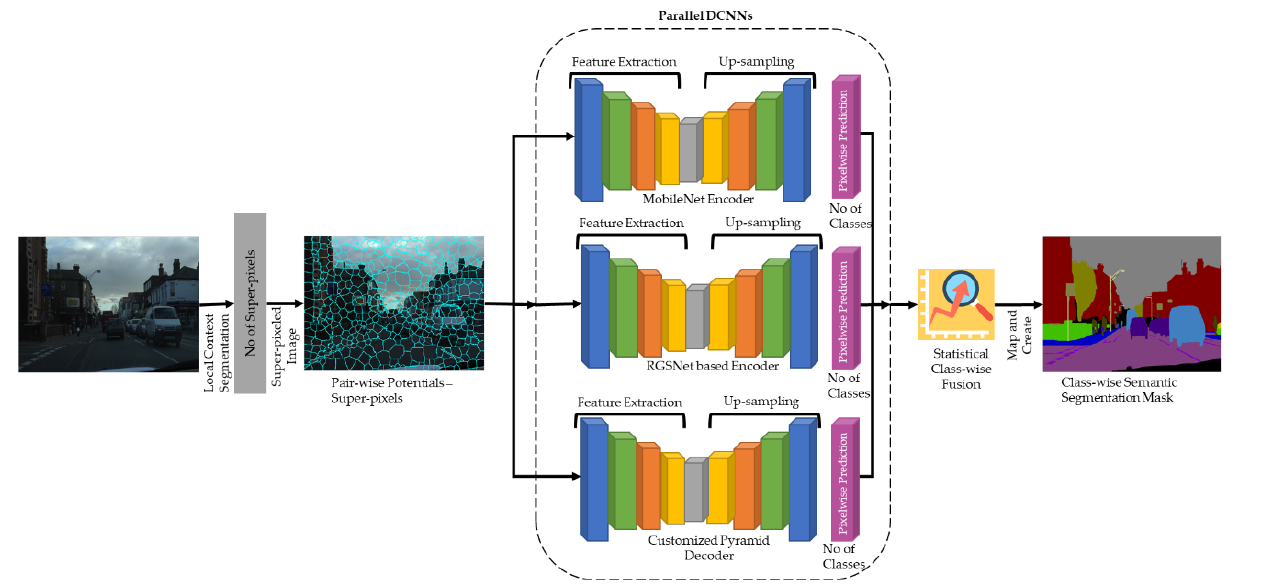
Figure 3. Proposed Parallel DCNN for Semi-dark Images.